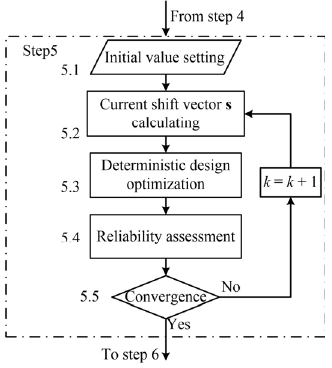
Figure 3. Detailed process of